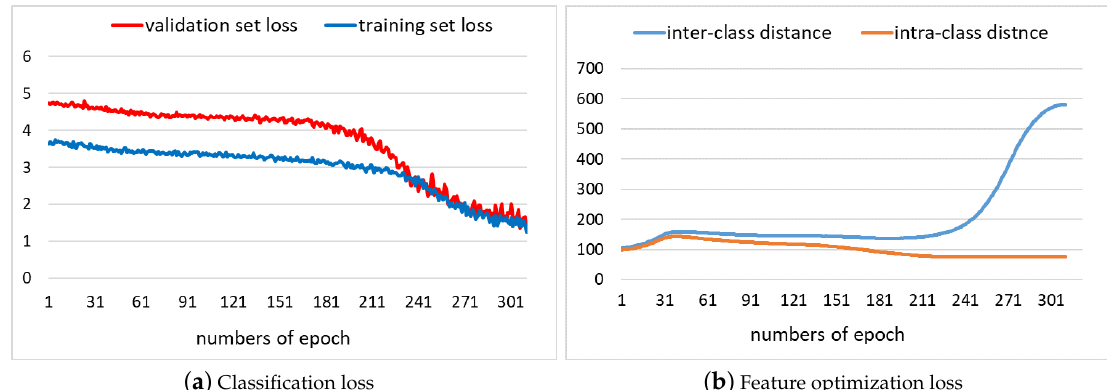
Figure 6. The classification loss curves and feature optimization loss curves with